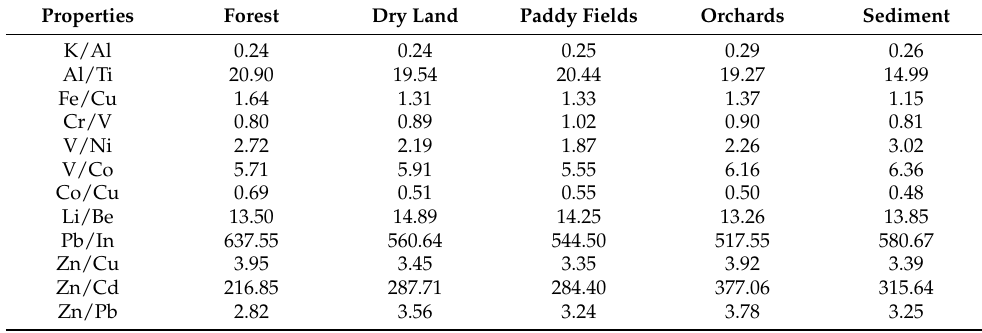
Table 3. Mean values of element ratios of sources and